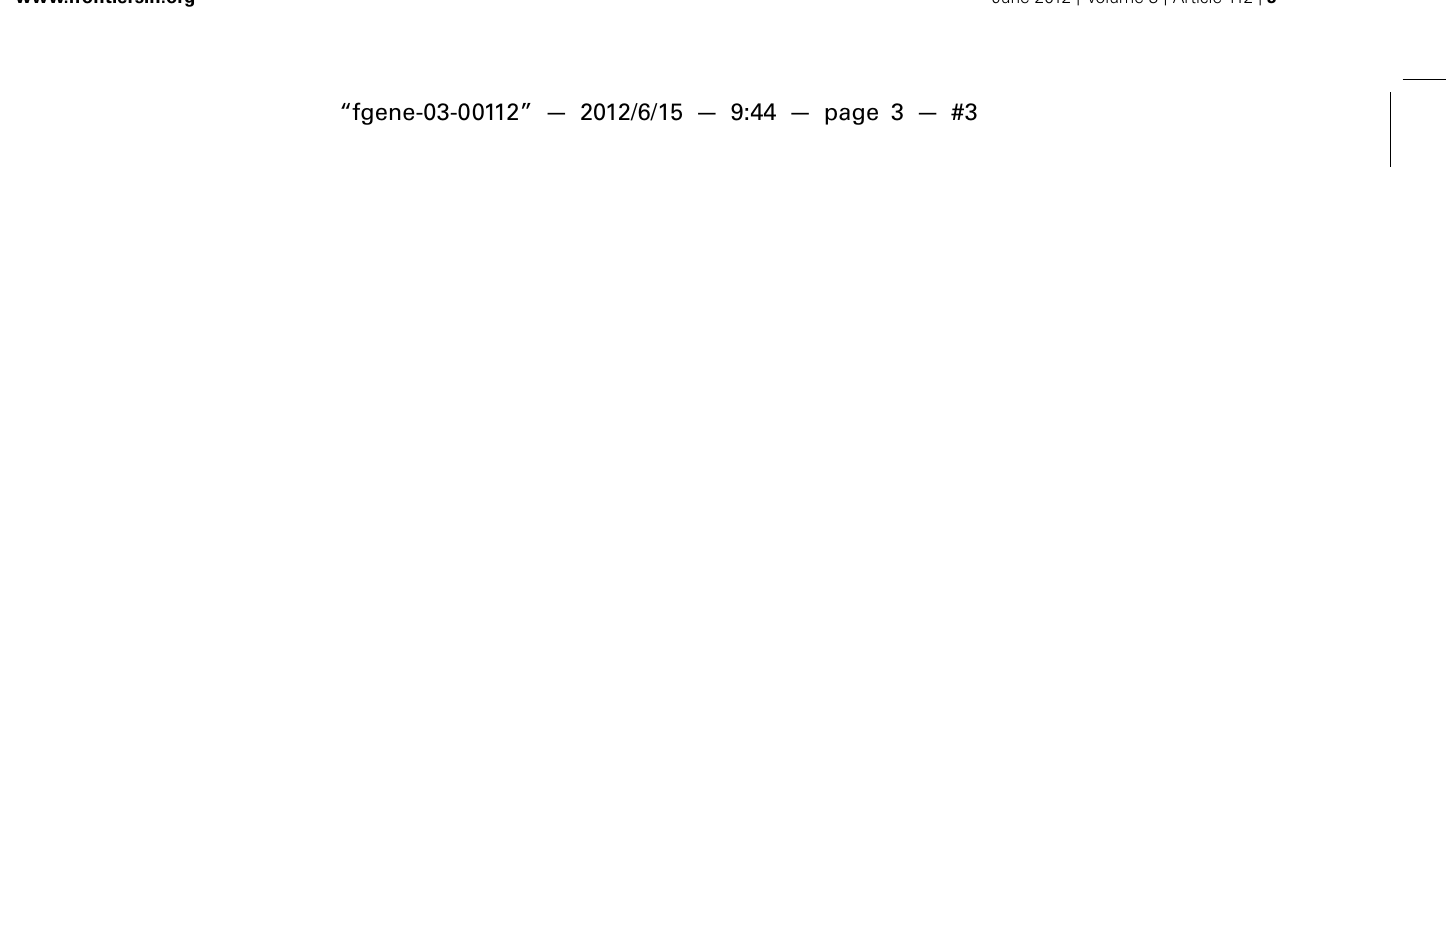
FIGURE 1 | Schematic representation of the prophase of meiosis I. (A) The critical steps that affect chromosomal segregation in meiosis I. During the pre-meiotic S-phase, both maternal (red) and paternal (green) chromosomes are replicated and tightly connected to cohesin complexes (purple circles). Then, two homologous chromosomes undergo pairing, and a synaptonemal complex (pink ladder) is established between them. HR results in the production of at least one obligatory chiasma via crossover. After the disassembly of SC, two homologous chromosomes are pulled in opposite directions to the two spindle poles (gray). (B) Schematic representation of meiotic recombination. Initially, programmed DSBs are induced by SPO11 endonuclease (pink circles).The 5 (cid:2) -ends of the DSBs are then resected and the 3 (cid:2) -protruding single-stranded ends are generated.With the aid of RAD51